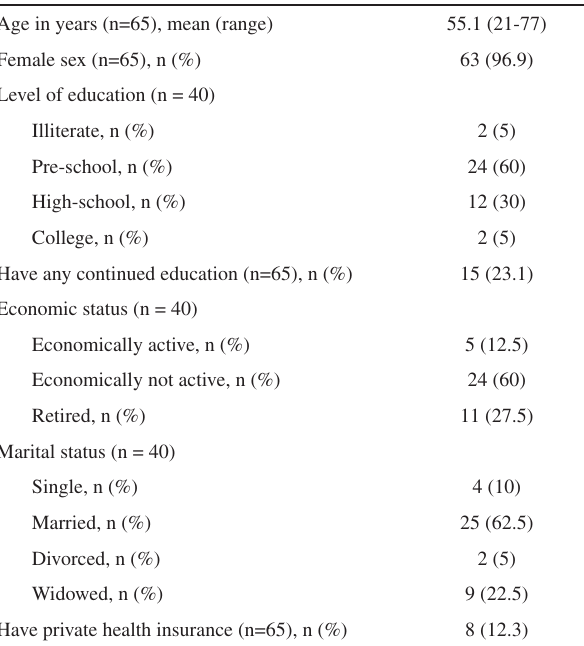
Table 1 - Demographic data characterizing the study group Age in years (n=65), mean (range)